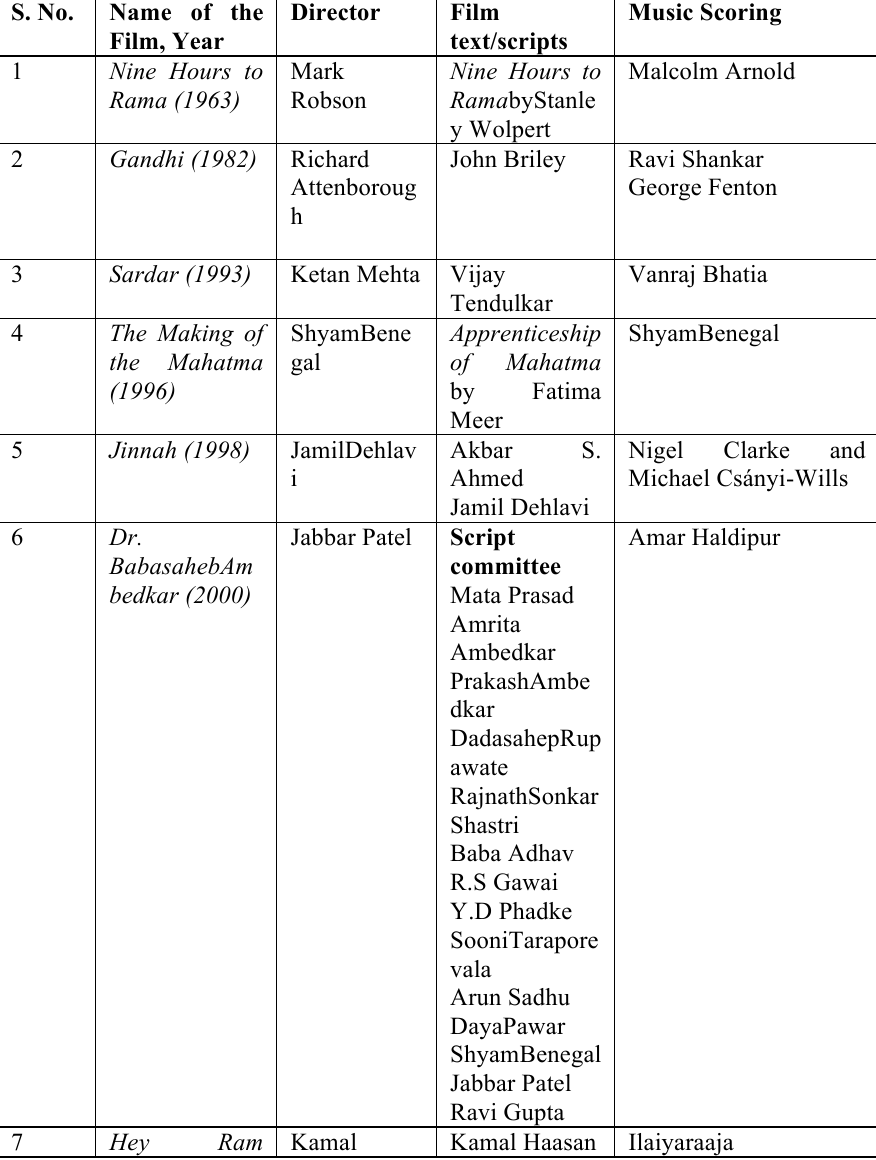
Table 4: Details of the text/script writing/script committee & music scoring in the universe of Gandhi